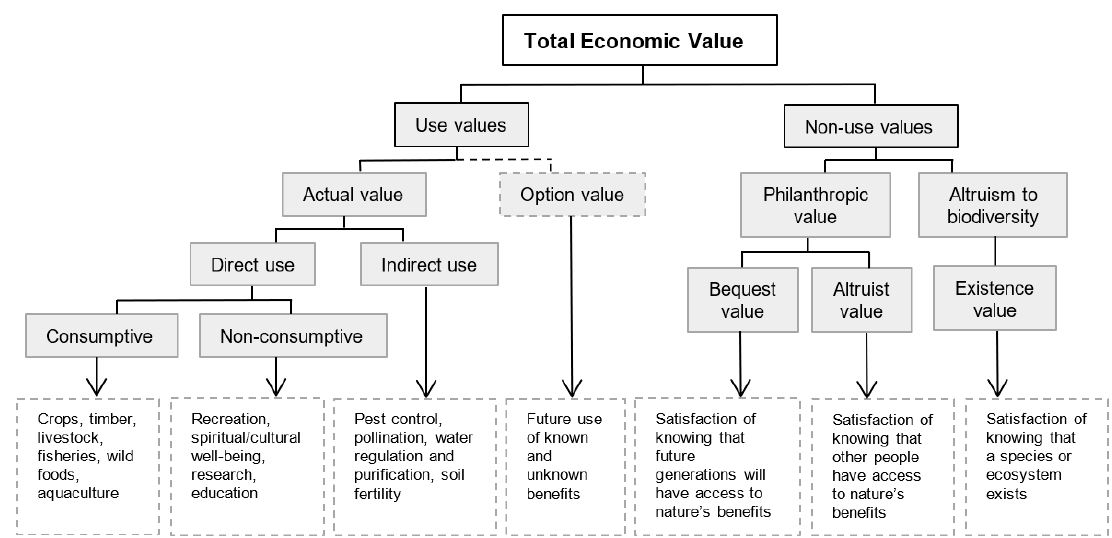
Figure 2. TEV typology adapted from [77], which classifies values associated with direct use, indirect use, and non-use of service flows generated by natural capital.